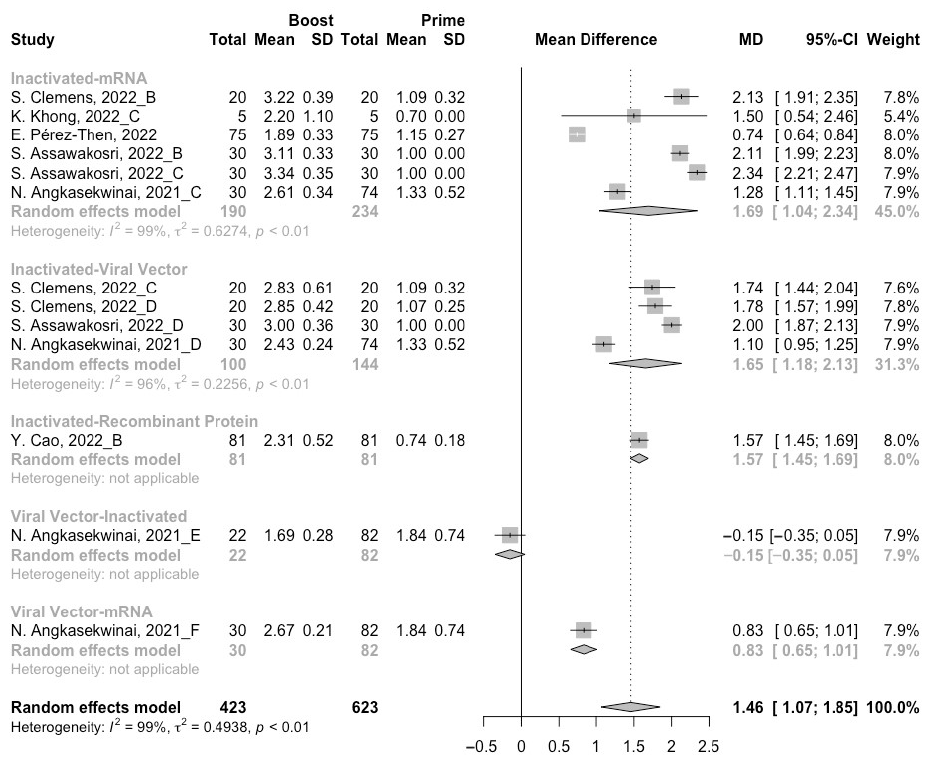
Figure 11. Forest plot of the pooled log-transformed neutralization titers against the Delta variant before and after heterologous booster vaccination [2,18–32].